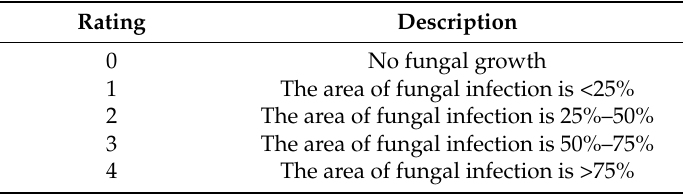
Table 1. Rating scale for assessment of fungal